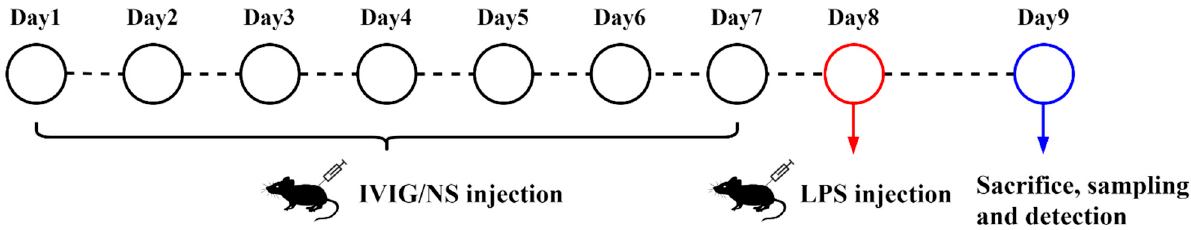
Figure 5. Experimental schedule. NS, normal saline; LPS, lipopolysaccharide.